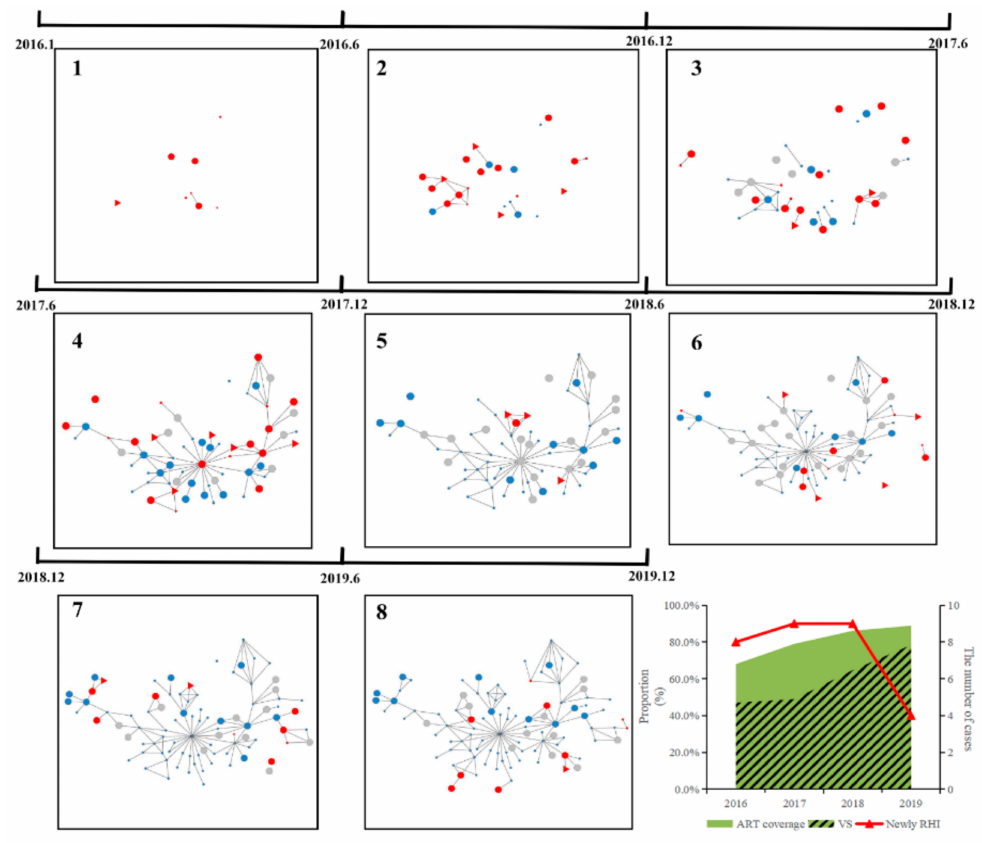
Figure 2. Dynamic analysis of the largest CRF01_AE cluster expansion and antiretroviral therapy during 2016 to 2019. The pictures 1–8 shows the outbreak process of the largest CRF01_AE cluster from Jan 2016 to Dec 2019. Red represents newly diagnosed PLWH, and blue represents those previously diagnosed. Circles represent CHI, and triangles represent RHI. Node size represents each case’s most recent VL. The gray circle represents individuals previously diagnosed with VL- unavailable. The combination diagram shows the specific data for this cluster. Green represents ART coverage, and blue represents the proportion of individuals with VS. The red line shows the change in the number of newly diagnosed